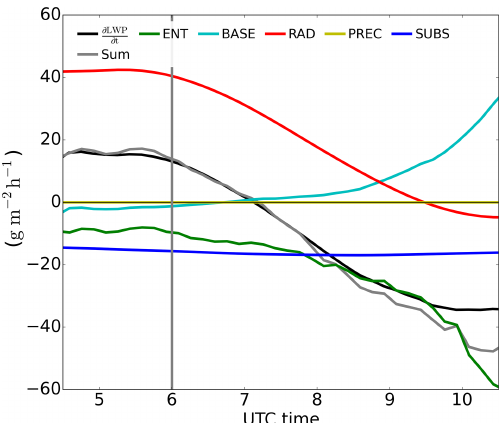
Figure 6. Time series of budget terms as defined in Eqs. (2) and (3) with colors representing the terms as displayed in the legend, and the sum grey line being the sum of all the terms on the right-hand side of Eq. (2). The vertical grey line indicates sunrise